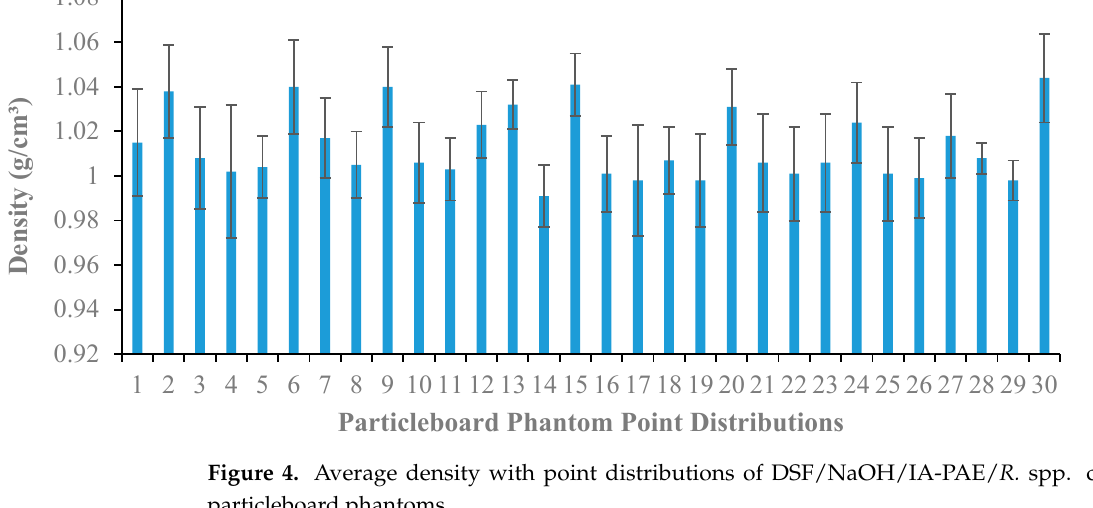
Figure 4. Average density with point distributions of DSF/NaOH/IA-PAE/ R. spp. composite particleboard phantoms.